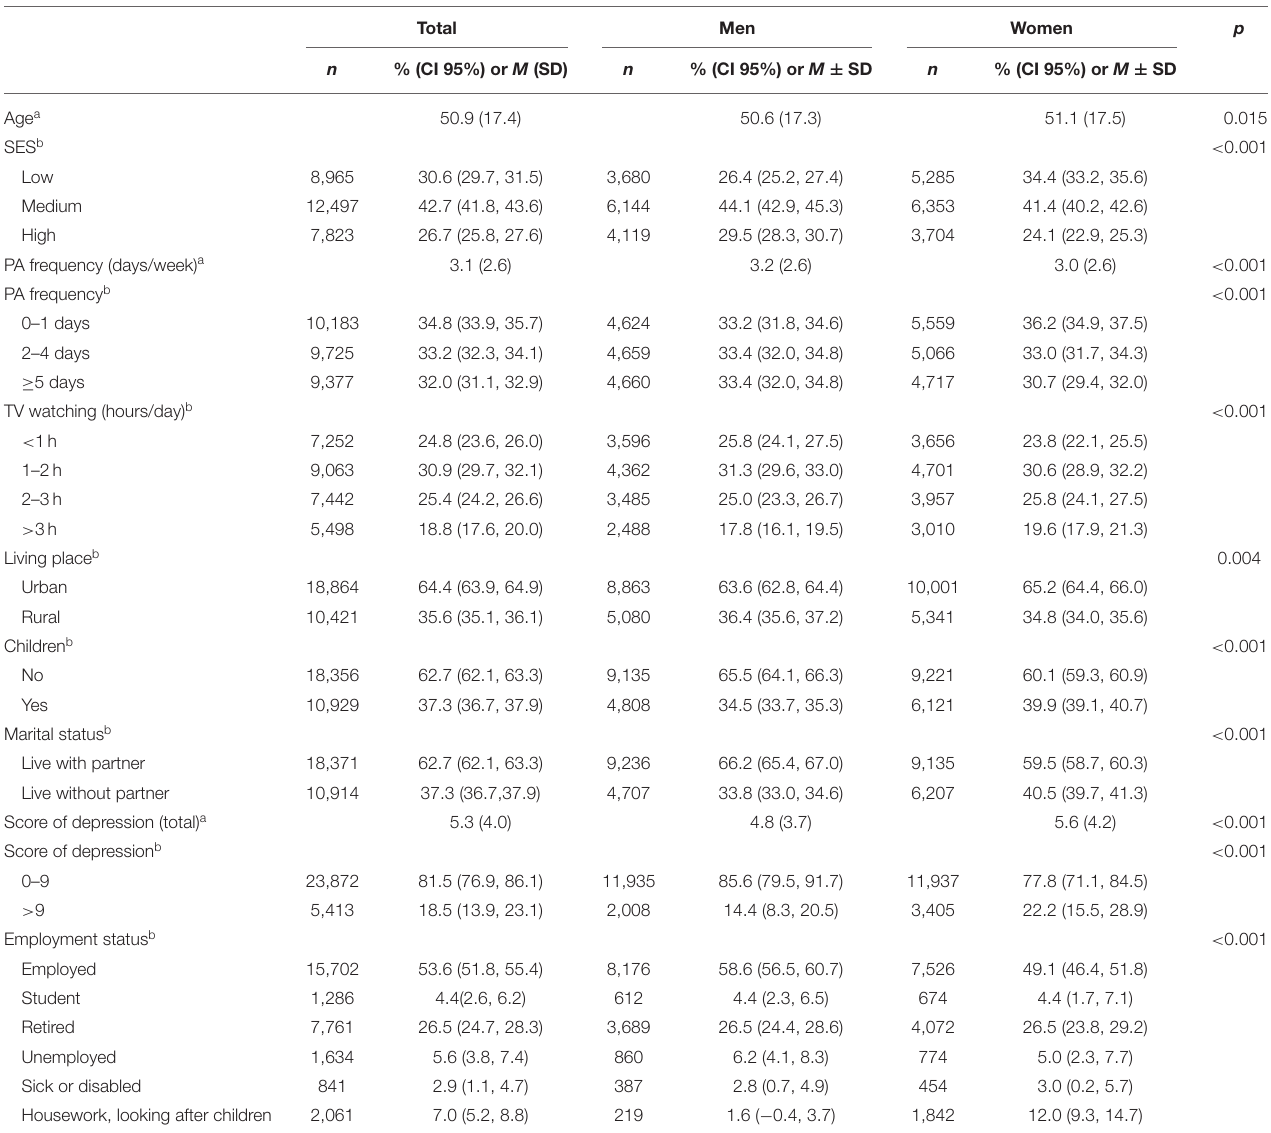
TABLE 1 | Participants’ characteristics stratified by sex in 2014.